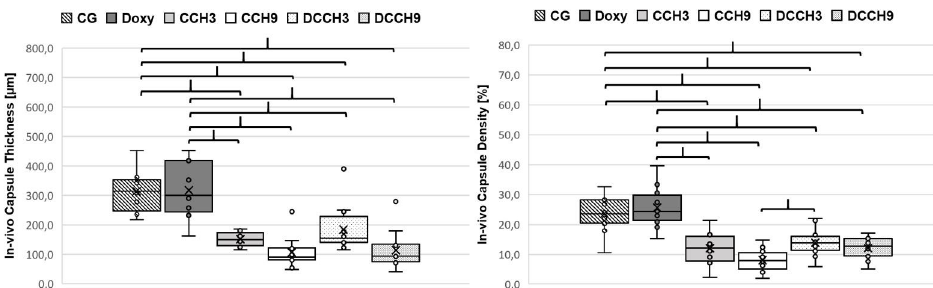
Fig 8. In-vivo results of capsule measurements. left) capsule thickness and right) capsule collagen density measurements. Mean values (X) are graphed on a box plot and individual data points are shown. Density is measured as percentage of stained pixels in relation to the whole image pixel count. Brackets indicate statistically significant differences (p < 0.0083). Group size: n = 12.